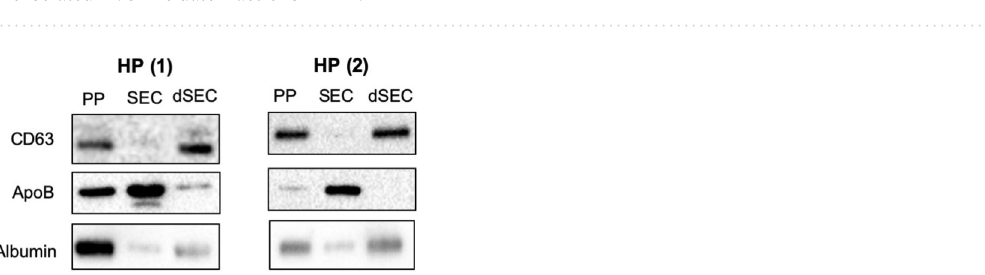
Figure 4. Removal of aggregated LDLs and soluble proteins by dSEC columns. ( a ) Schemetic representation of the developed dual size-exclusion chromatography (dSEC) column. ( b ) Western blot analysis and Ponceau S staining, with equal protein loading, of CD63, ApoB and soluble proteins (MW: 35–75 kDa) upon separation of AML BM plasma by the dSEC column. ( c ) Relative intensities of bands in ( b ) (n = 3). EV-collecting fractions are highlighted in red. ( d ) TEM image of EVs in eluate fractions 11–12. Scale bar: 100 nm. ( e ) Size distribution of the isolated EVs in eluate fractions 11–12.